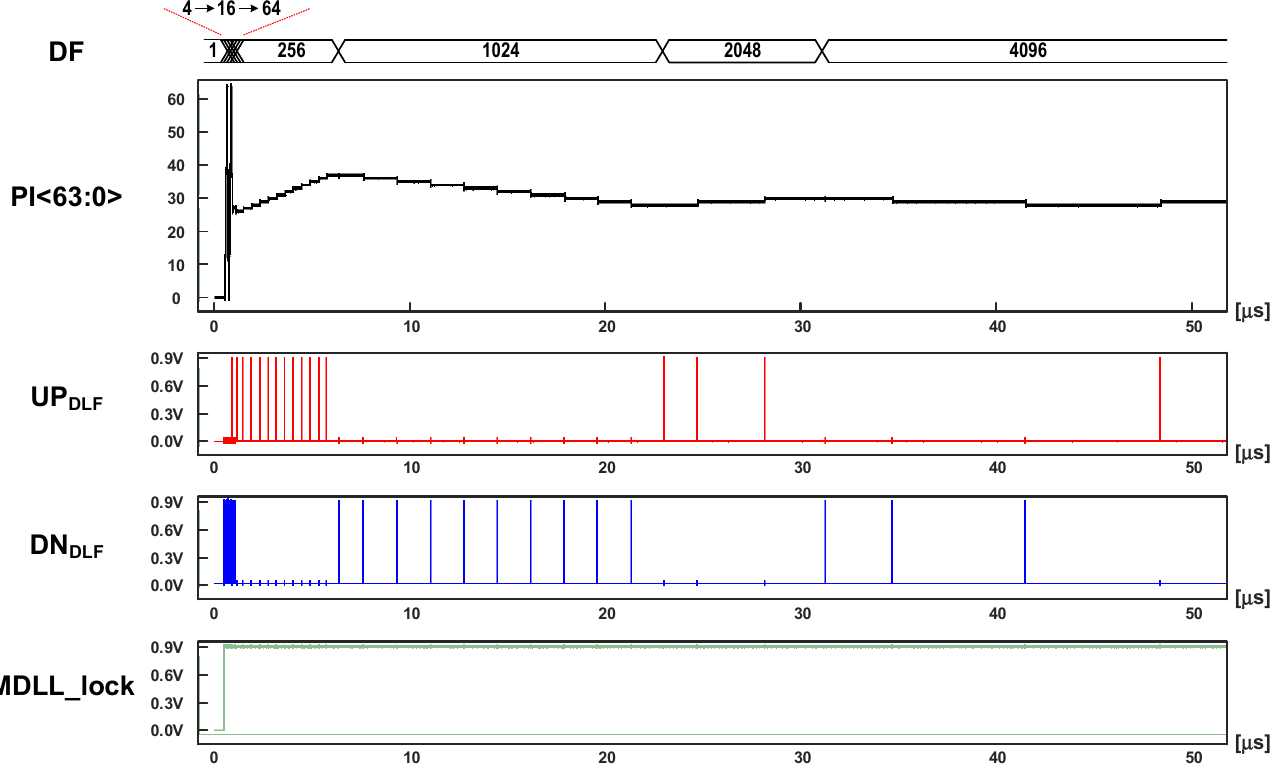
Figure 10. Post-layout simulated locking process of proposed DJA.